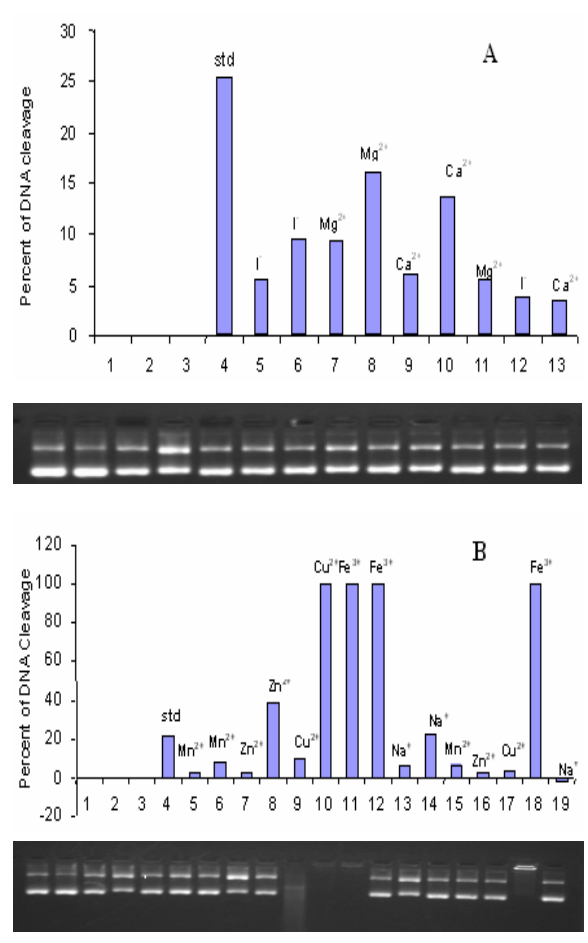
Figure 1 : Effect of biologically relevant inorganic ions on the light-induced DNA cleavage by pyrene (60 μ M). Lanes 1, 2, 3 are negative controls and lane 4 is the positive control. The lower bands in the gel are that of the sc-DNA and the upper bands are that of the oc-DNA. The concentrations for various ions are: 50 mM for I - , Na + , Ca 2+ , Mg 2+ and 0.5 mM for the transition metals Mn 2+ , Zn 2+ , Fe 3+ , and Cu 2+ . Experiments with all ions are under three conditions: (1) Dark control: Ion + DNA + pyrene without irradiation (Lanes 5, 7, 9 in A and 5, 7, 9, 11, 13 in B); (2) Effect of ion on DNA cleavage by pyrene: ion + DNA + pyrene with 1 h of irradiation (Lanes 6, 8, 10 in A or 6, 8, 10, 12, 14 in B); (3) Light O with 1 h of irradiation: control: ion + DNA + H 2 (Lanes 11, 12, 13 in A or 15, 16, 17, 18, 19 in B). Figure 1 are the negative controls: DNA alone without light irradiation (lane 1), DNA alone with light irradiation (lane 2), and DNA + 60 μ M pyrene without irradiation (lane 3). They all have the same percent of oc-DNA indicating that exposure to light alone (lane 2) and pyrene alone (lane 3) does not cause any cleavage to the DNA. Lane 4 is the positive control with DNA and 60 μ M pyrene with 1h of irradiation. It shows that about 26% of the sc-DNA is cleaved. The tests for each ion are with dark control (ion + pyrene + DNA without irradiation) and light control (ion + DNA with irradiation) in addition to the regular test (ion + pyrene + DNA with irradiation). The dark control experiments confirm that all ions except Fe 3+ cause only minimal